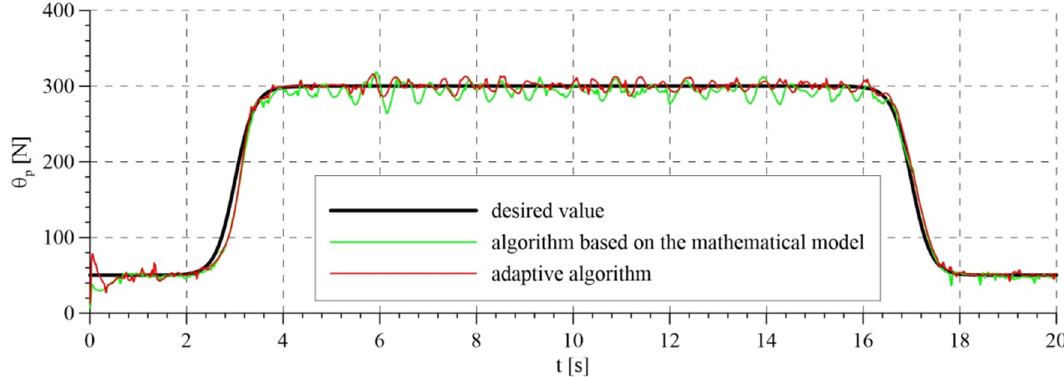
Figure 11. Disturbance of the system—displacement of the patient’s torso.